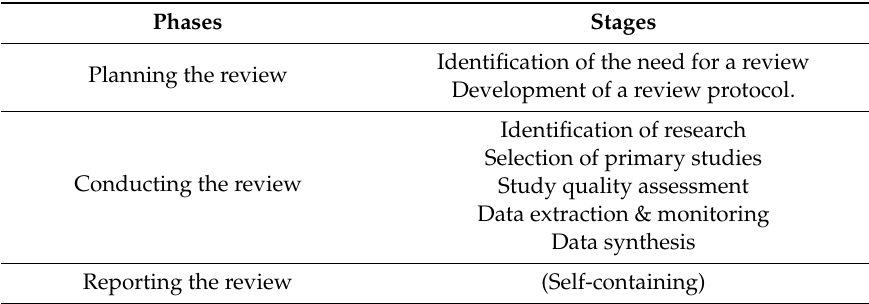
Table 2. Systematic literature review